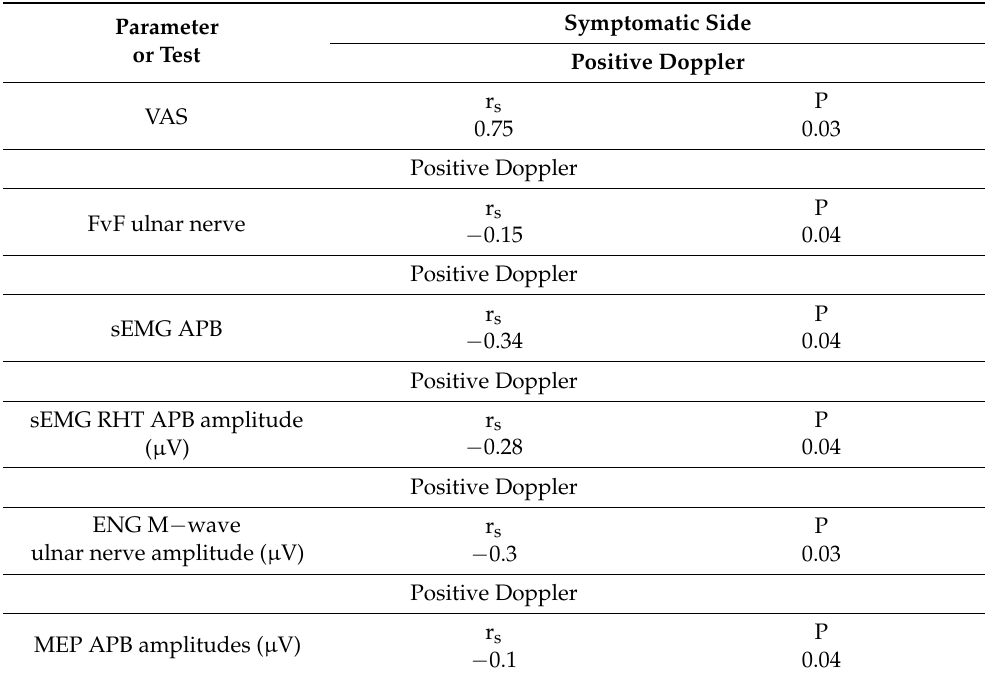
Table 4. Spearman’s rank correlation (r s ) of the test results obtained in clinical and neurophysiological studies on the symptomatic side in TOS patients. P- values < 0.05 are assumed, for rank correlation, to be statistically